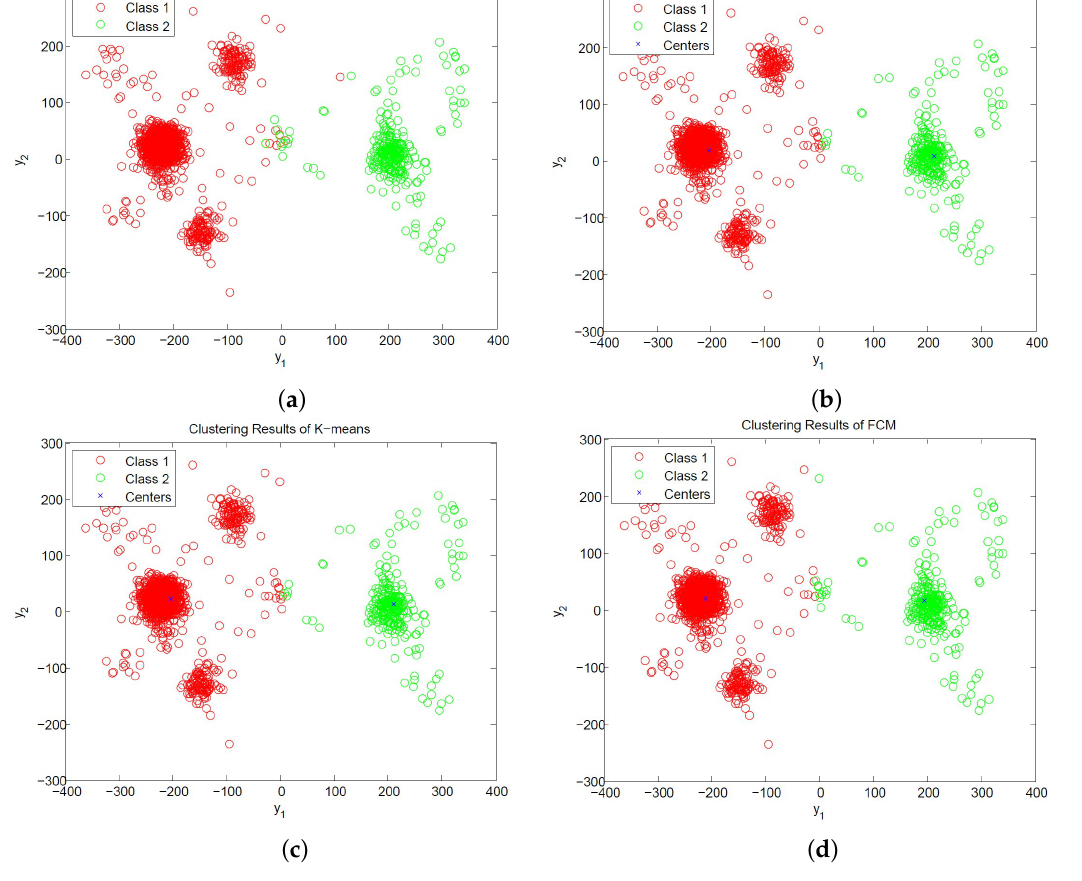
Figure 12. The distribution of PCA feature vectors of spikes and the results of CL, K-means and FCM clustering for SNR = 1 dB. ( a ) Ground truth of neuron spikes; ( b ) clustering results produced by CL; ( c ) clustering results produced by K-means; ( d ) clustering results produced by